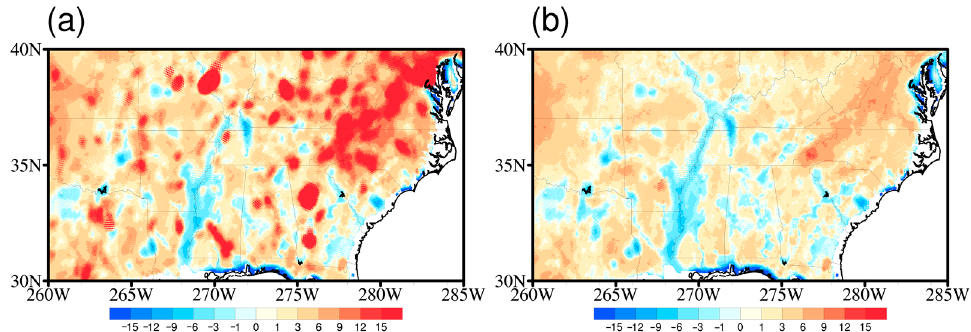
Figure 7. Averaged OMB before ( a ) and after ( b ) the restoration for the 6.9-GHz-V channel in au-